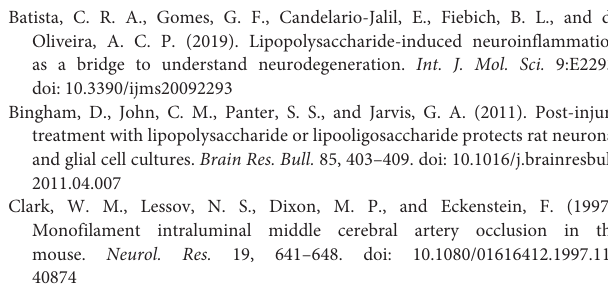
FIGURE S1 | Pre-conditioning by LPS did not significantly influence body temperature. (A) Timeline of the experimental procedure, (B) rectal temperature, (C) LDF recordings above the middle cerebral artery territory assessed in mice exposed to transient intraluminal MCAO. Vehicle or LPS (1 mg/kg) was intraperitoneally administered at 24 h prior to MCAO. No differences were noted between the groups. Results are means ± SD values ( n = 4 animals/group). FIGURE S2 | LPS preconditioning reduces infarct volume and increases neuronal survival in the ischemic brain. Panel (A) shows representative cresyl violet (infarcted tissue outlined), Darpp-32 and NeuN staining in the ipsilesional striatum of mice exposed to sham surgery or intraluminal MCAO which were treated with vehicle or LPS (0.1 or 1 mg/kg) at 24 h after MCAO. Quantifications of infarct volume (B) , Darpp-32+ neurons in the ipsilesional striatum (C) and NeuN+ neurons (D) are provided. Data are means ± SD values. ** p < 0.01 compared with vehicle group ( n = 4 animals/group). Scale bars, 1 mm. FIGURE S3 | LPS pre-conditioning does not influence the post-ischemic astrogliosis. Panel (A) shows representative immunostainings of GFAP+ reactive astrocytes. GFAP immunoreactivity was quantified (B) in the entire ipsilesional and contralesional hemispheres (striatum plus cortex) of mice exposed to sham surgery or transient intraluminal MCAO. Vehicle or LPS (1 mg/kg) was intraperitoneally administered at 24 h prior to MCAO. No differences were noted between the groups. Data are means ± SD values ( n = 4 animals/group). Scale bars, 1 mm. FIGURE S4 | LPS preconditioning attenuates post-ischemic microglia/macrophage activation. The density of Iba1+ microglia/macrophages (A) and Iba1+ cell activation index (B) were quantified in striatum and cortex of mice exposed to sham surgery or transient intraluminal MCAO. Vehicle or LPS (1 mg/kg) was intraperitoneally administered at 24 h prior to MCAO. Data are means ± SD values. * p < 0.05 compared with vehicle group ( n = 4 animals/group). Scale bars, 10 µ